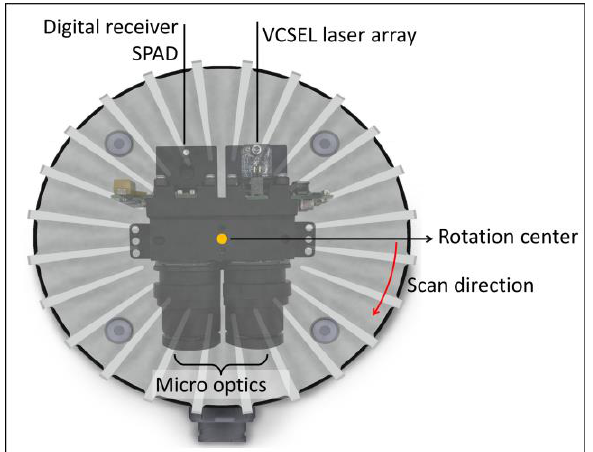
Figure 2. Ouster optical module composed of micro-optics, SPAD and VCSEL technologies (adapted from Pacala and Frichti, 2020).